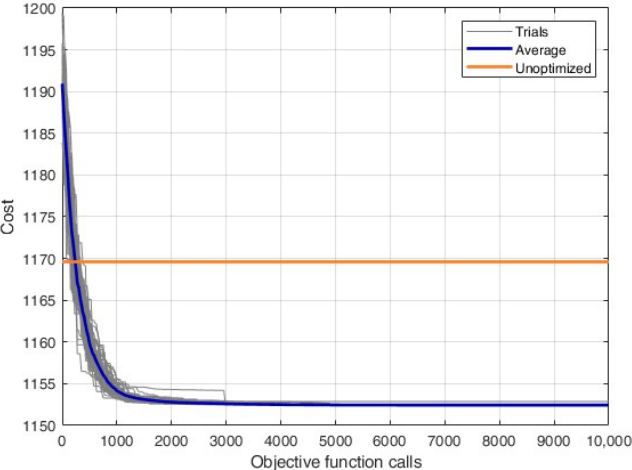
Figure 15. Convergence curves for the optimisation with labour cost. Each grey line represents one of the 50 independent trials; the blue line is the average convergence; and the orange line is the cost value of the unoptimised solution.